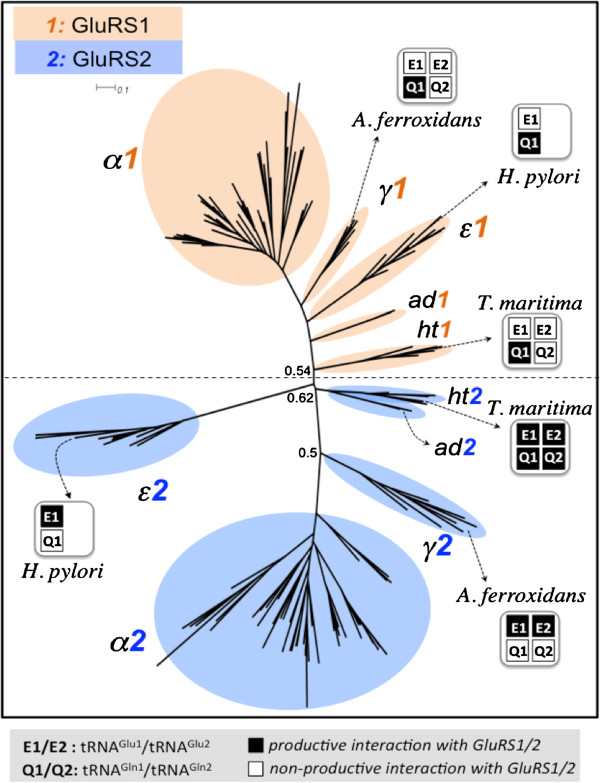
Phylogeny of bacterial GluRS1 and GluRS2. Phylogenetic tree of bacterial GluRS1 and GluRS2 sequences (listed in Additional file 5) and annotated with bacterial phyla (abbreviations in Table 1). Experimentally determined glutamylation capacity of both GluRS1 and GluRS2 for selected bacterial species (H. pylori, A. ferrooxidans and T. maritima) with the two isoacceptors of tRNAGlu (E1: 34UUC and E2: 34CUC) and tRNAGln (Q1: 34UUG and Q2: 34CUG), are projected in the respective clades, as productive or non-productive (empty/filled symbols). Branch support values < 0.7, calculated using aLRT statistics, are indicated.